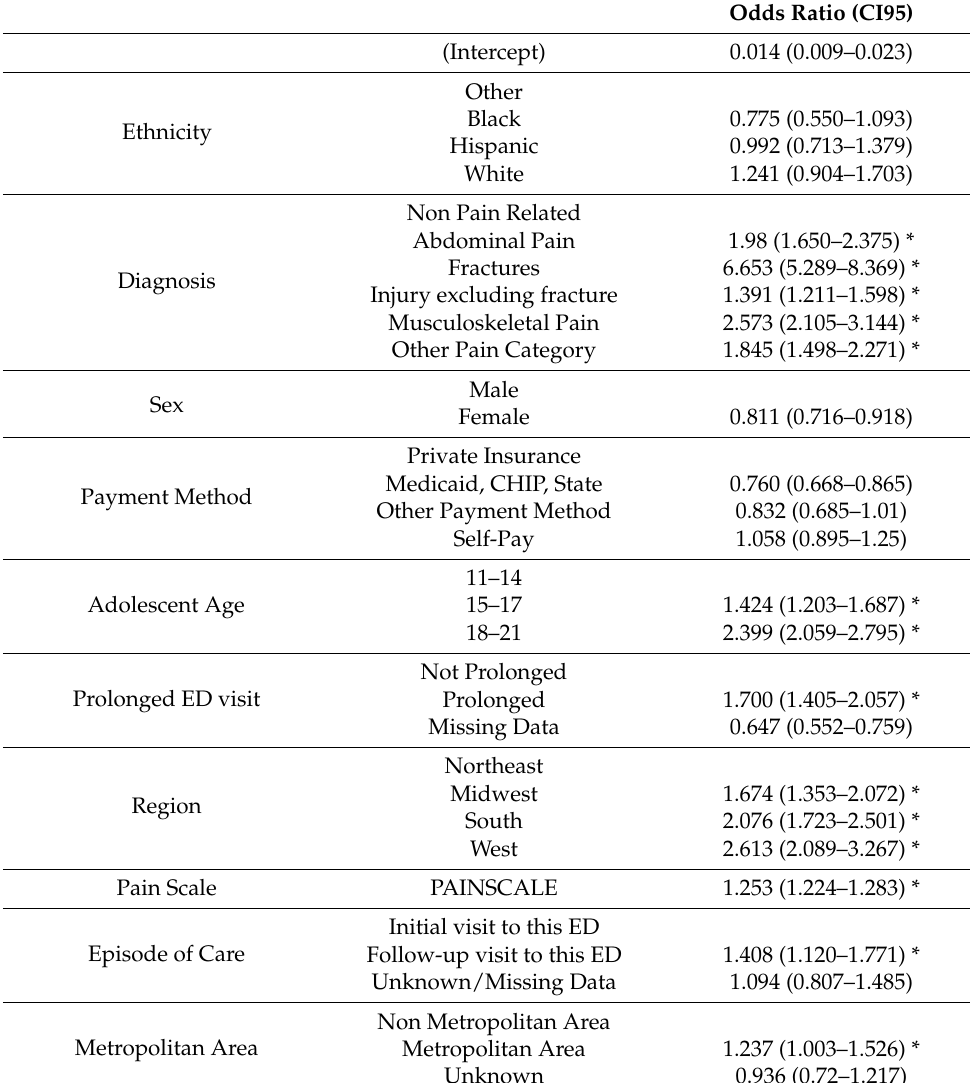
Table 2. Logistic Regression Analysis of Predictors of Adolescent ED Opioid